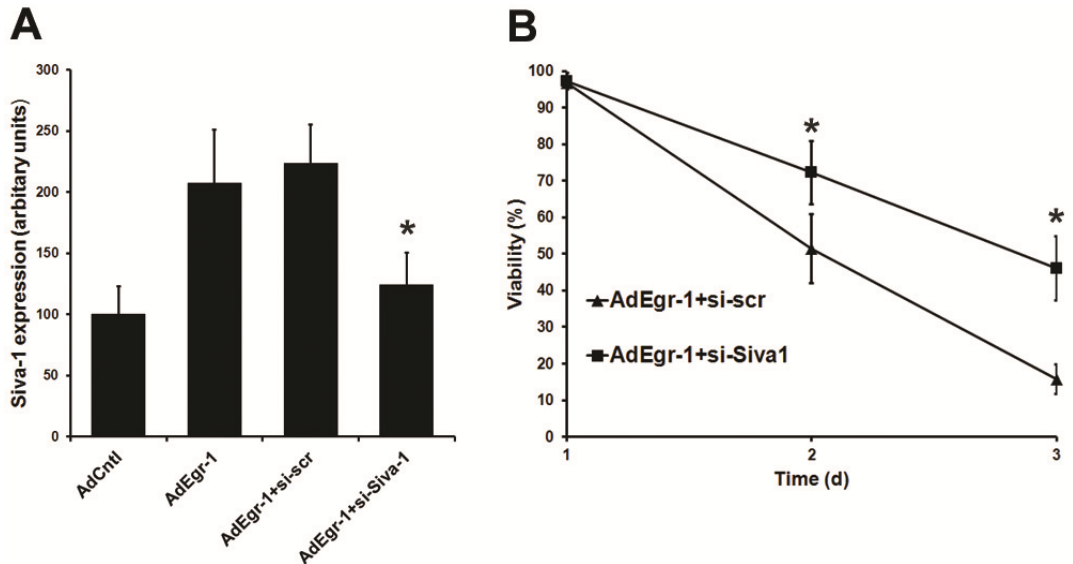
Figure 4. Suppression of Siva-1 expression reduces Egr-1 mediated cardiac fibroblast apoptosis. ( A ) Prior transfection with siRNA directed against Siva-1 (si-Siva-1) reduces Siva-1 mRNA 48 h post AdEgr-1 infection compared to scrambled siRNA controls (si-scr) as assessed by real time RT-PCR; and ( B ) Transfection with si-Siva-1 increases cell viability in AdEgr-1 infected cultures compared to si-scr controls. Data incorporate the standard deviation of three experiments ( * p <